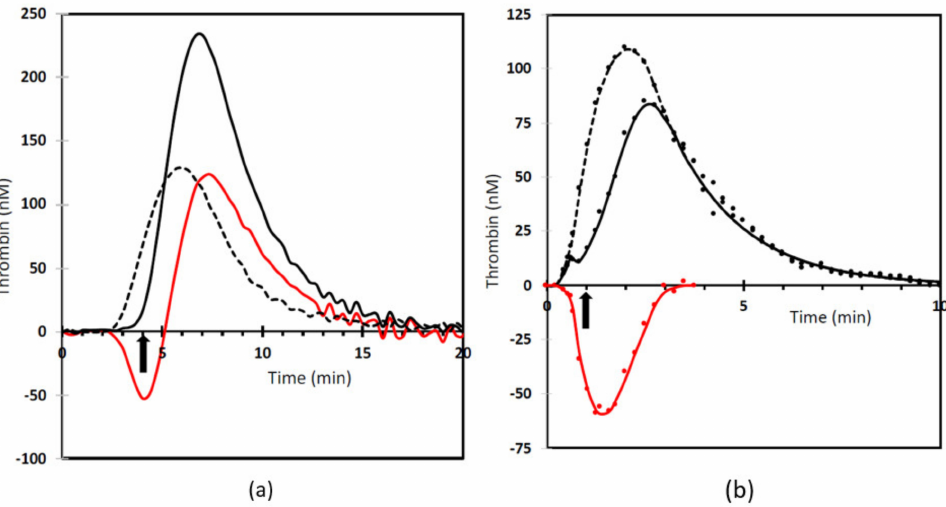
Figure 1. The effect of fibrin on thrombin generation. ( a ) measurement from added substrate where both the clot and fluid compartment are measured (based on [19]). ( b ) measurement using the subsampling method (based on [20]). Drawn line: normal plasma. Dotted line: defibrinated plasma. Red line: difference between normal and defibrinated plasma. The arrow indicates the moment of